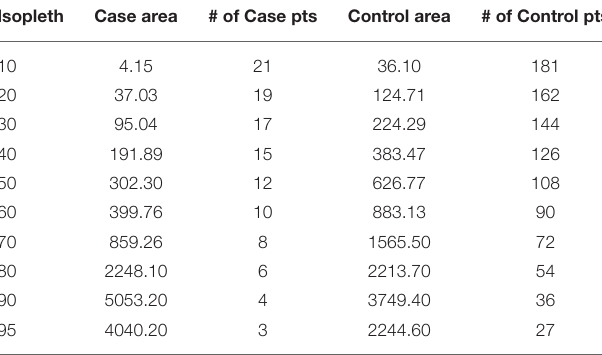
TABLE 2 | The area (km 2 ) and number of points generated per isopleth in the Case mortality occurrence probability distribution and Control utilization distribution based on a starting density of 5 points per km 2 , with subsequent weighting proportionate to the isopleth’s associated probability.